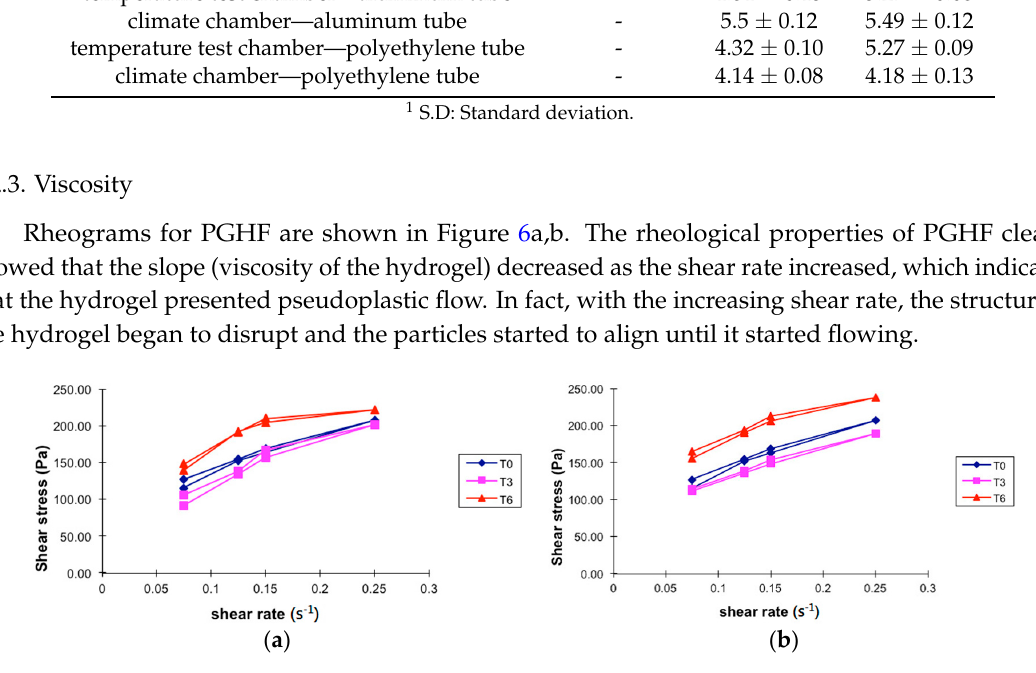
Figure 6. Share stress—share rate curves of hydrogel-based formulation of ethanolic extract of P. granatum (2%, w / w ); T0: after production, T3: 3 months and T6: 6 months of storage under different storage conditions. ( a ) Temperature test chamber; ( b ) Climatic chamber. Results are represented by means ( n = 3).